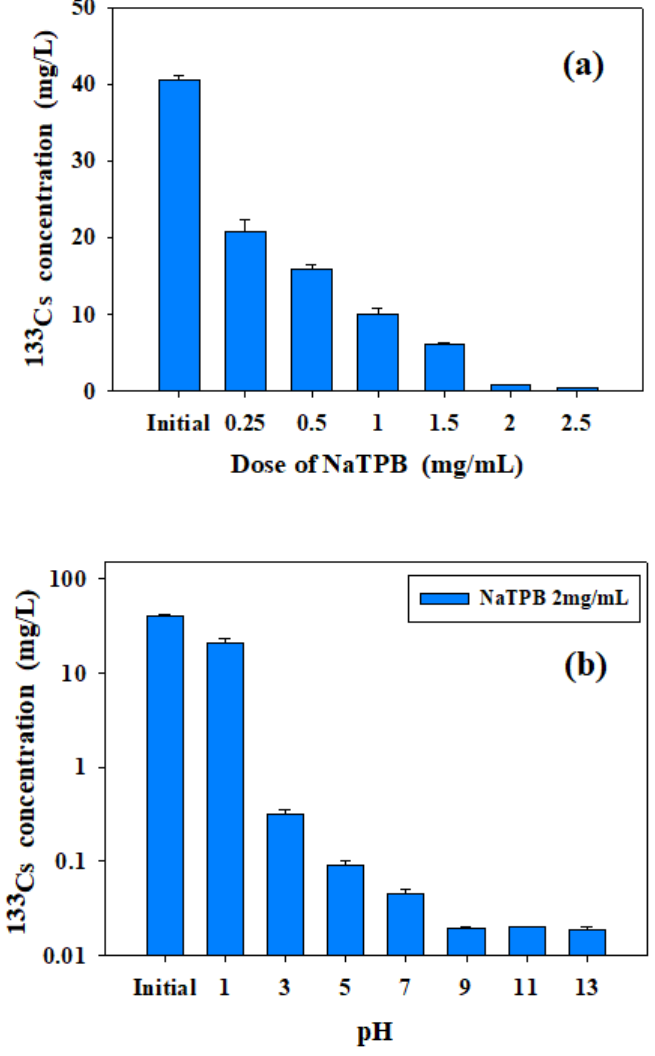
Figure 7. After treatment with 0.15 M oxalic acid from 133 Cs-HBT contaminated clay minerals, ( a ) the optimal dosage of NaTPB to remove 133 Cs ions from the washing wastewater ( b ) is in the optimal pH range. (n = 2, mean ± standard error of mean).